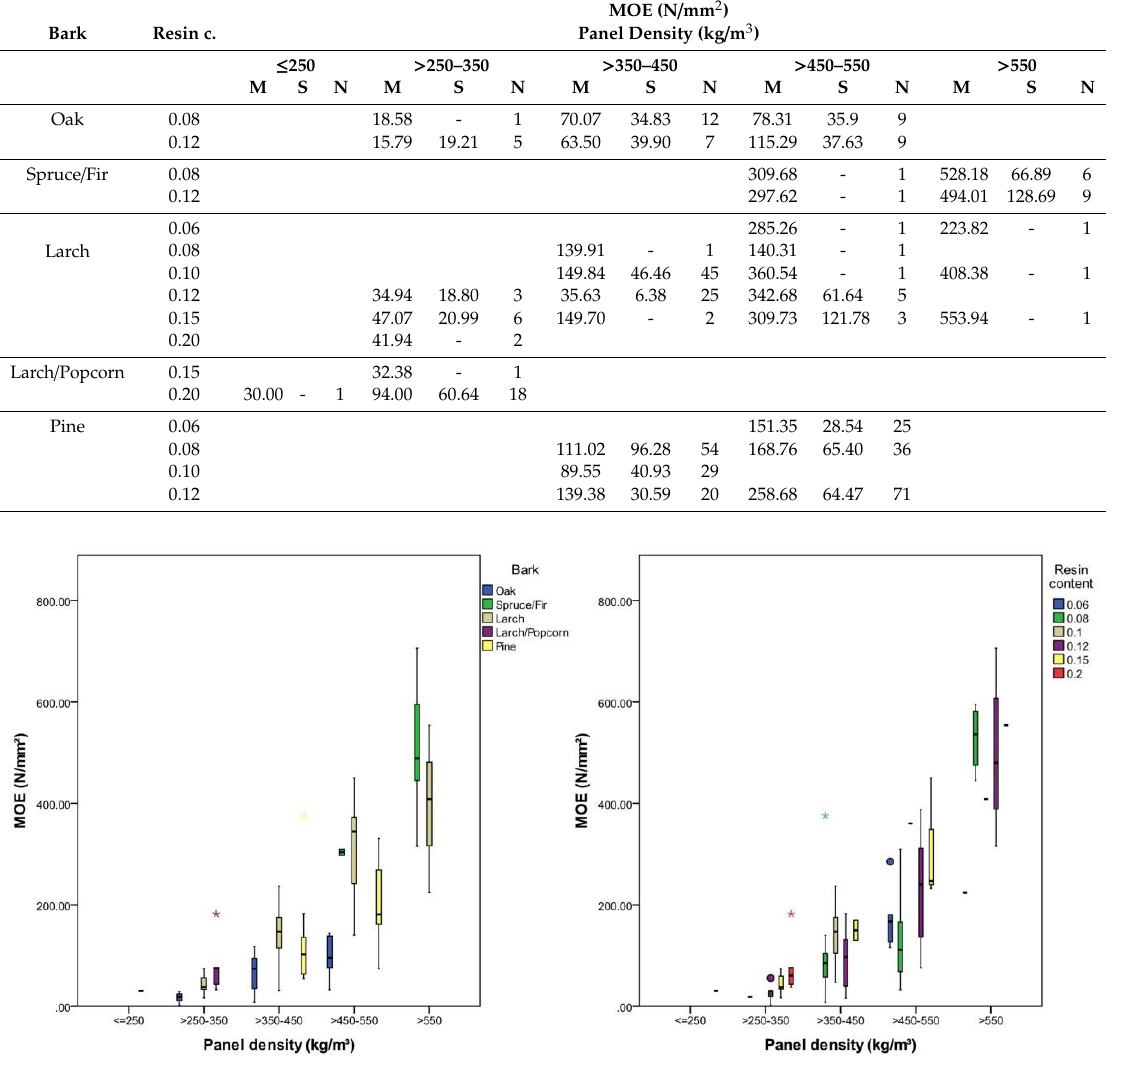
Table 6. MOE dependent on bark and resin content.